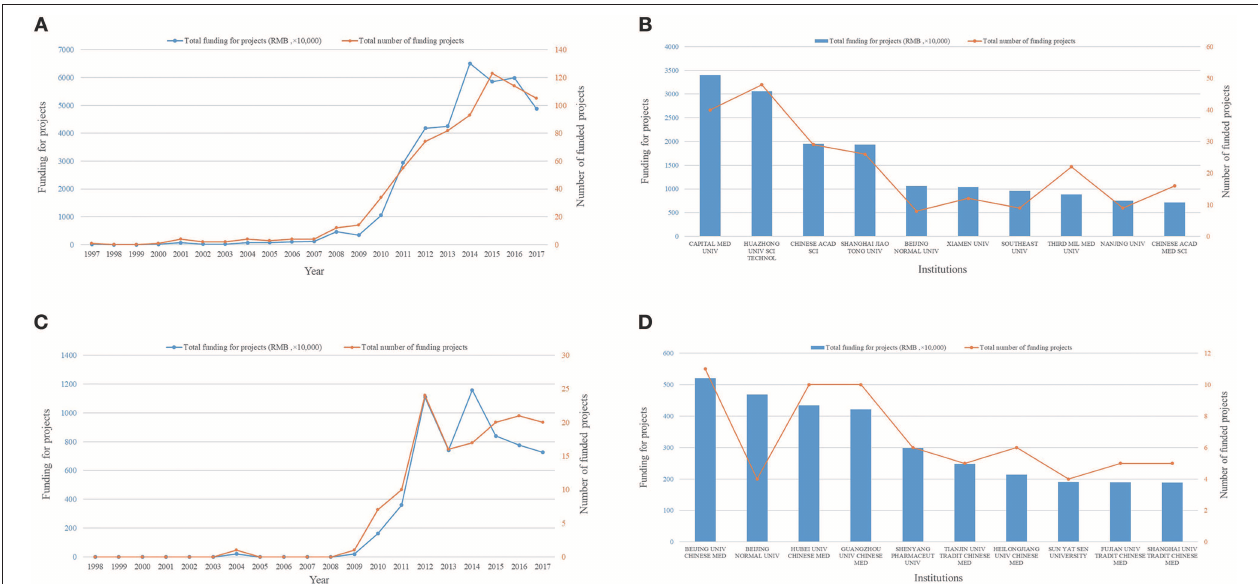
FIGURE 8 | NSFC funding, NSFC-funded institutions, and NSFC growth trends in China. (A) NSFC funding from 1997 to 2017. The blue curve indicates the total amount of funding and the orange curve indicates the number of projects. (B) NSFC funding of AD research at different Chinese institutions. Blue bars indicate the total amount of funding and the orange curve indicates the number of projects. (C) NSFC funding for studies on the mechanism of traditional Chinese medicine in AD from 1997 to 2017. The blue curve indicates the total amount of funding and the orange curve indicates the number of projects. (D) NSFC funding for studies on the mechanism of traditional Chinese medicine in AD at different Chinese institutions. Blue bars indicate the total amount of funding and the orange curve indicates the number of projects.